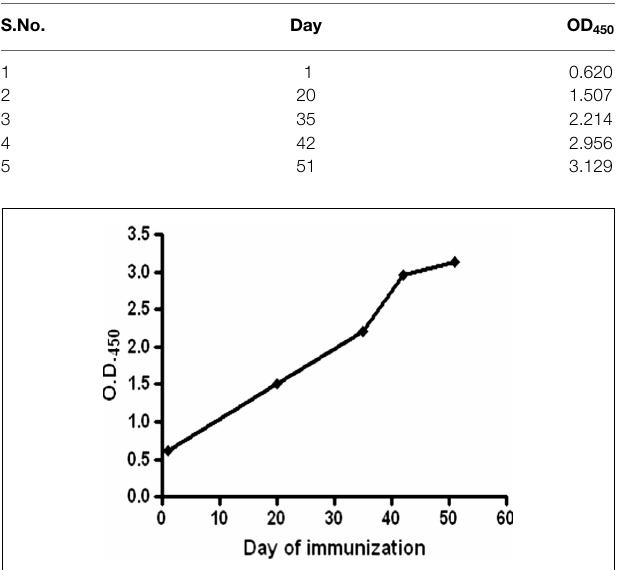
FIGURE 1 | Graphical representation of the mean antibody titers in sera of immunized mice before each immunization . High anti-HA antibody levels were detected in the hyper-immunized animals after 51days of the immunization schedule.